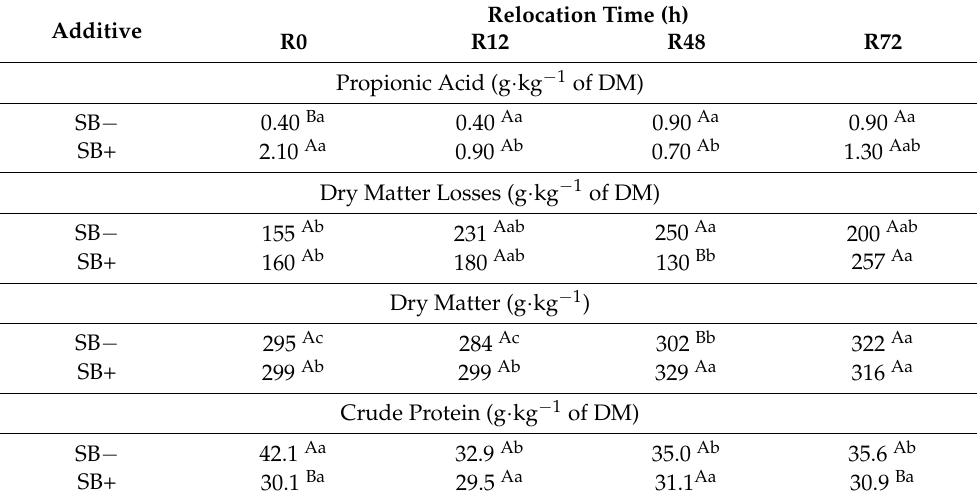
Table 3. The effects of the additive application and relocation time interaction (SB × R) on sugar- cane silage.